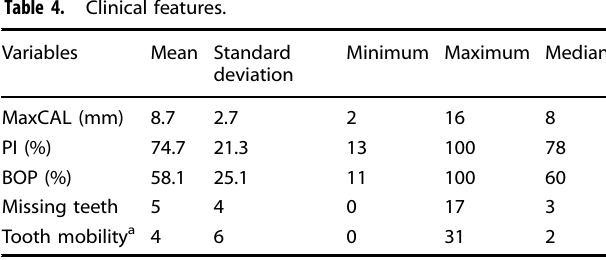
Table 4. Clinical features.